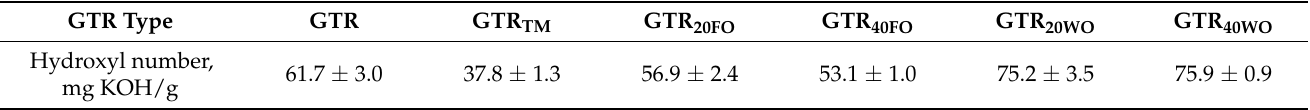
Table 1. Measured hydroxyl values of applied ground tire rubber (GTR) samples.